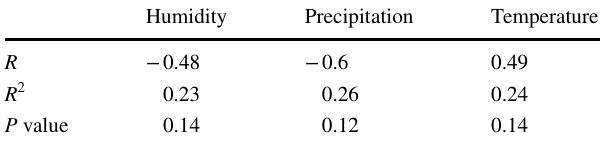
Table 2 Correlation between climatic parameters and methane in